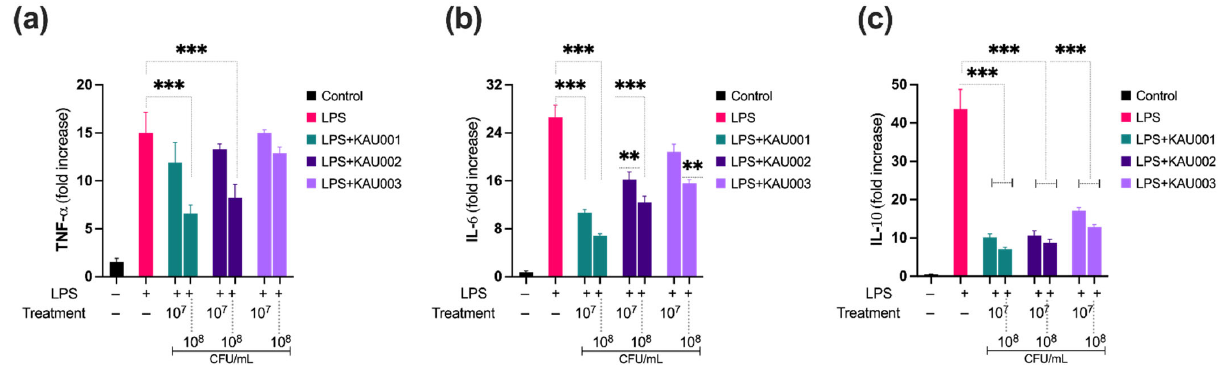
Figure 3. Anti ‐ inflammatory activities of LAB isolates in Raw 264.7 cells. Gene expression profile of ( a ) TNF ‐α , ( b ) IL ‐ 6, and ( c ) IL ‐ 10. Data are expressed as mean ± S.D. from three independent experiments. Bars with asterisks indicate significant differences as follows (** p < 0.005, *** p < 0.001). Bars with no asterisks depicts groups with no significance.